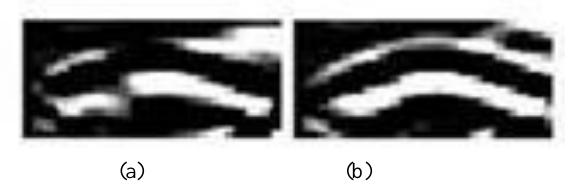
Figure 7: Signal contrast between (a) a damaged pipe and (b) an undamaged